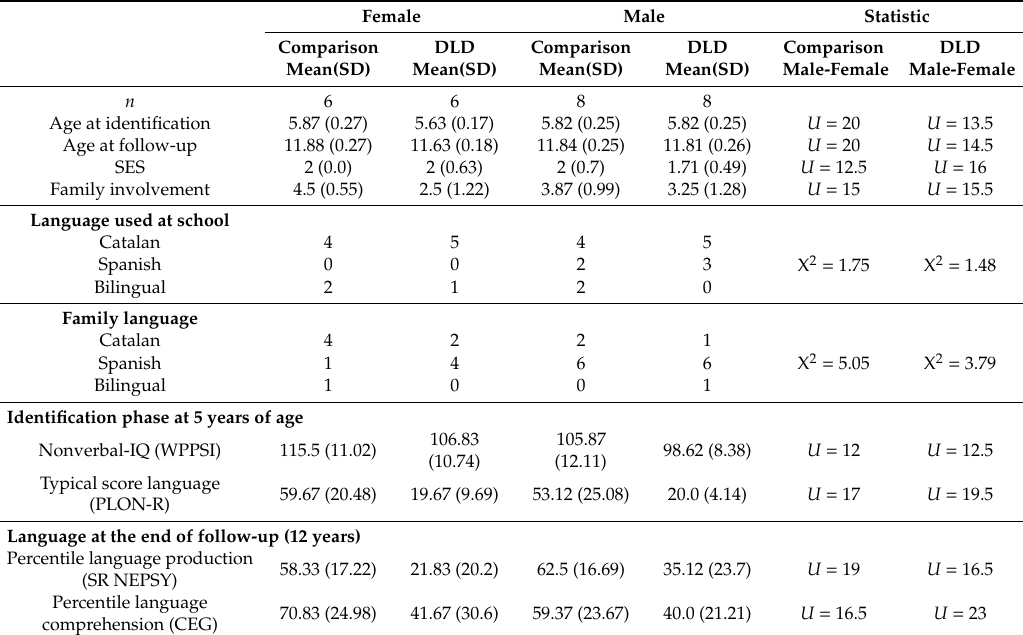
Table A1. Sociodemographic data split by